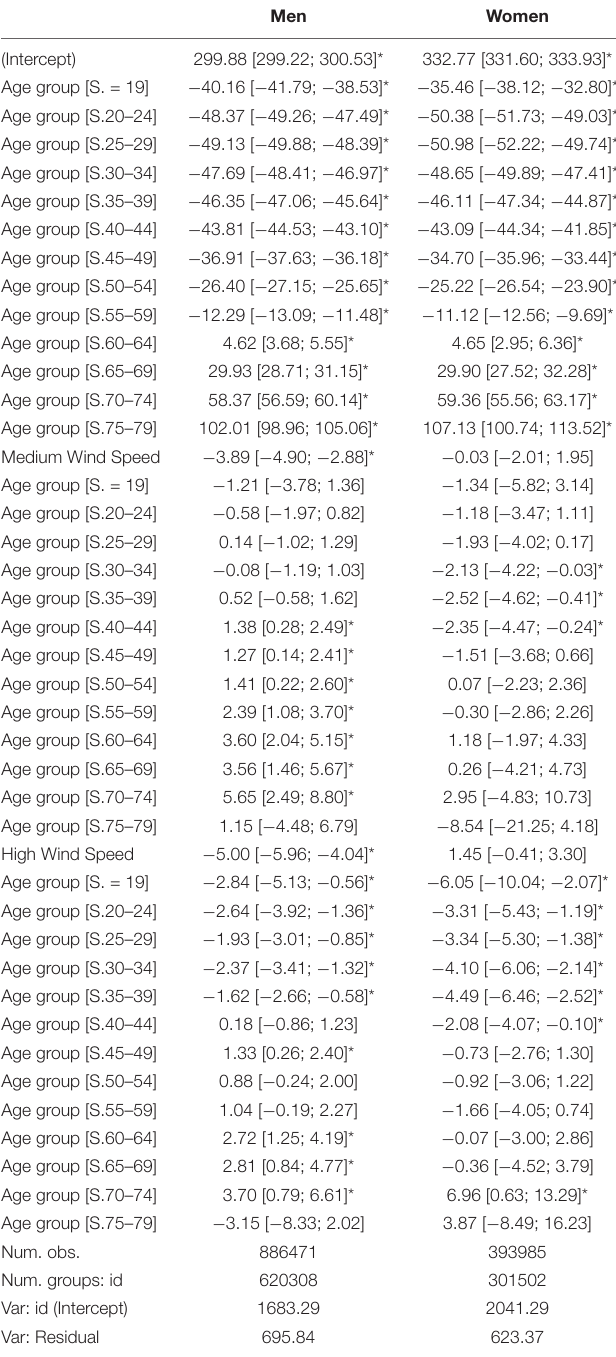
TABLE 5 | Linear mixed model for race time with age group and wind speed interaction. Men